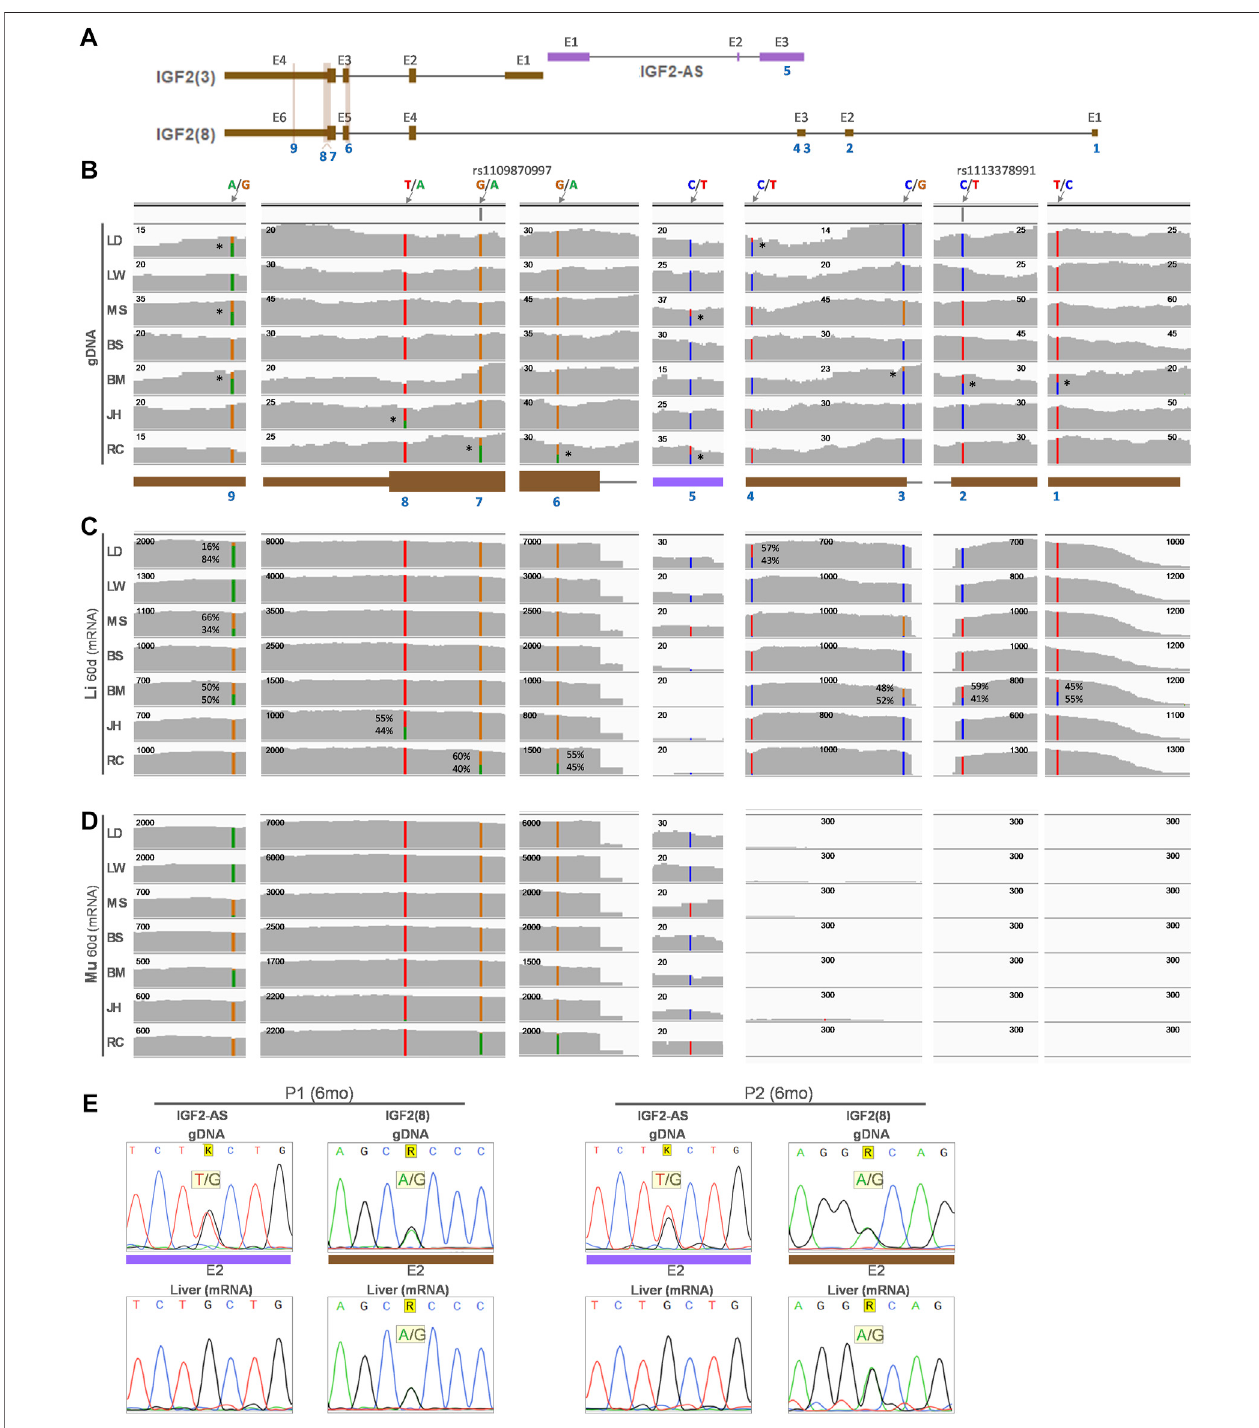
FIGURE5| Allelic expression ofthe IGF2 transcripts fromtheliverandskeletalmuscleof60-day-old pigsfrom9breeds. (A) Predominantporcine IGF2 transcripts in liver (Li) and skeletal muscle (Mu) from Figure 4 are displayed along with an antisense transcript ( IGF2-AS ). (B) Location of SNPs on genomic DNA (gDNA) analyzed usingWGS(PRJNA309108)aredenotedwithbluenumbers.Referenceandalternativeallelesaremarkedintheformatofref/alt(e.g.,A/G).Ifpresent,thereferenceSNP ID(rsID)isshown(e.g.,rs1109870997).Heterozygousallelesaredenotedwithstars(*)ontherightsideofSNPsinthegenomicDNA.ReadcoveragesofRNA-seq (GSE77776) from the same pigs as WGS are displayed for liver (C) and skeletal muscle (D) . Numbers on the top-left corner of each read coverage denote the depth of coverage. (E) Sequencingofexon2(E2)of IGF2(8) and IGF2-AS forgenomicDNAandcDNAfromthelivertissuesoftwo6-month-old(6 months)Berkshirepigs(P1and 2). LW, Large White; LD, Landrace; MS, Meishan; BS, Berkshire; BM, Bamei; JH, Jinhua; RC, Rongchang pigs.